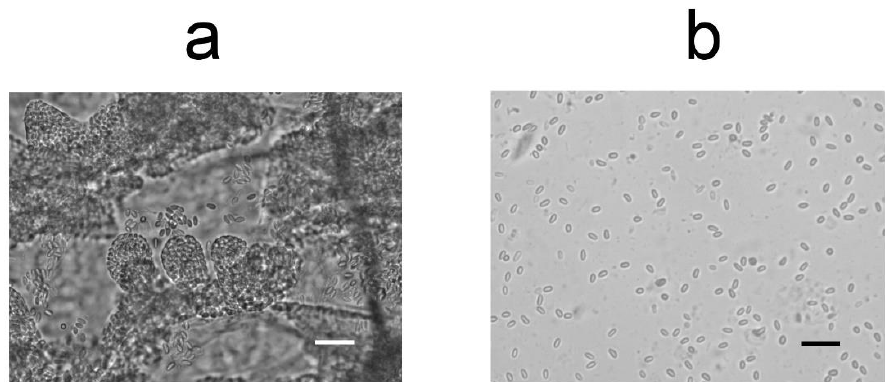
Figure 7. Light microscopy of artificially infected worker bees. ( a ) Segment of infected bee intestine after 30 days of V. ceranae cultivation; ( b ) homogenized infected bee intestine after 30 days of V. ceranae cultivation. Scale bars: 20 mkm.